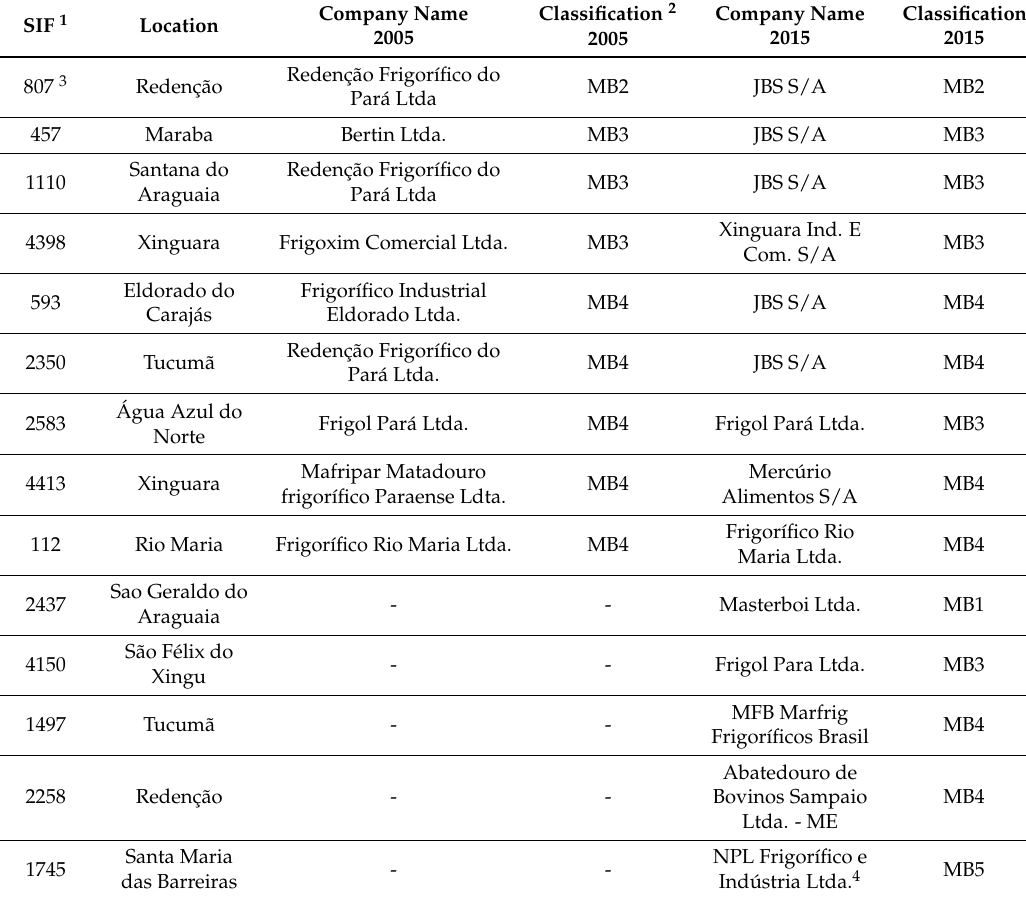
Table 6. Slaughterhouses with federal inspection (SIF) in the south of Pará in 2005 and